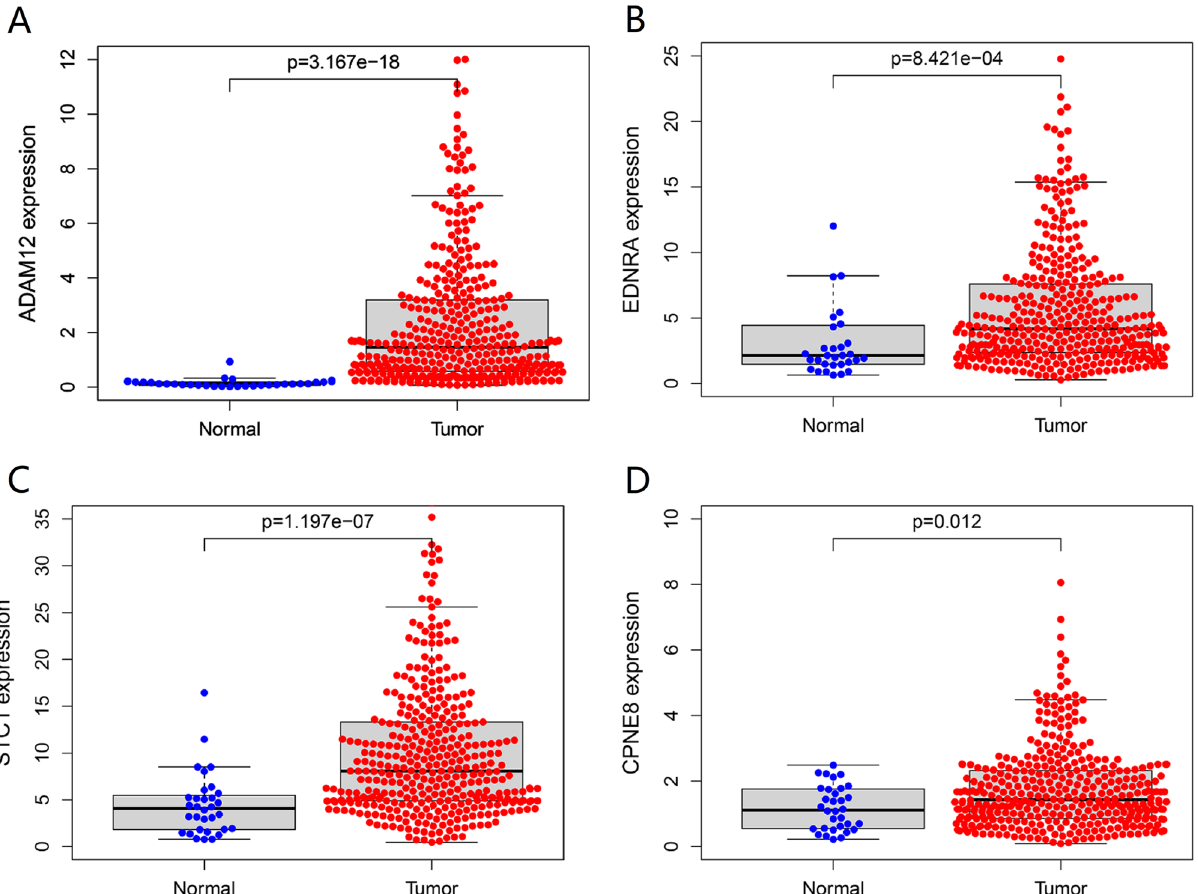
Figure 2. The expression levels of miR-30c-5p target genes in gastric cancer tissues and normal gastric tissues. The expression levels of ( A ) ADAM12, ( B ) EDNRA, ( C ) STC1 and ( D ) CPNE8 in GC tissues and normal gastric tissues (TCGA